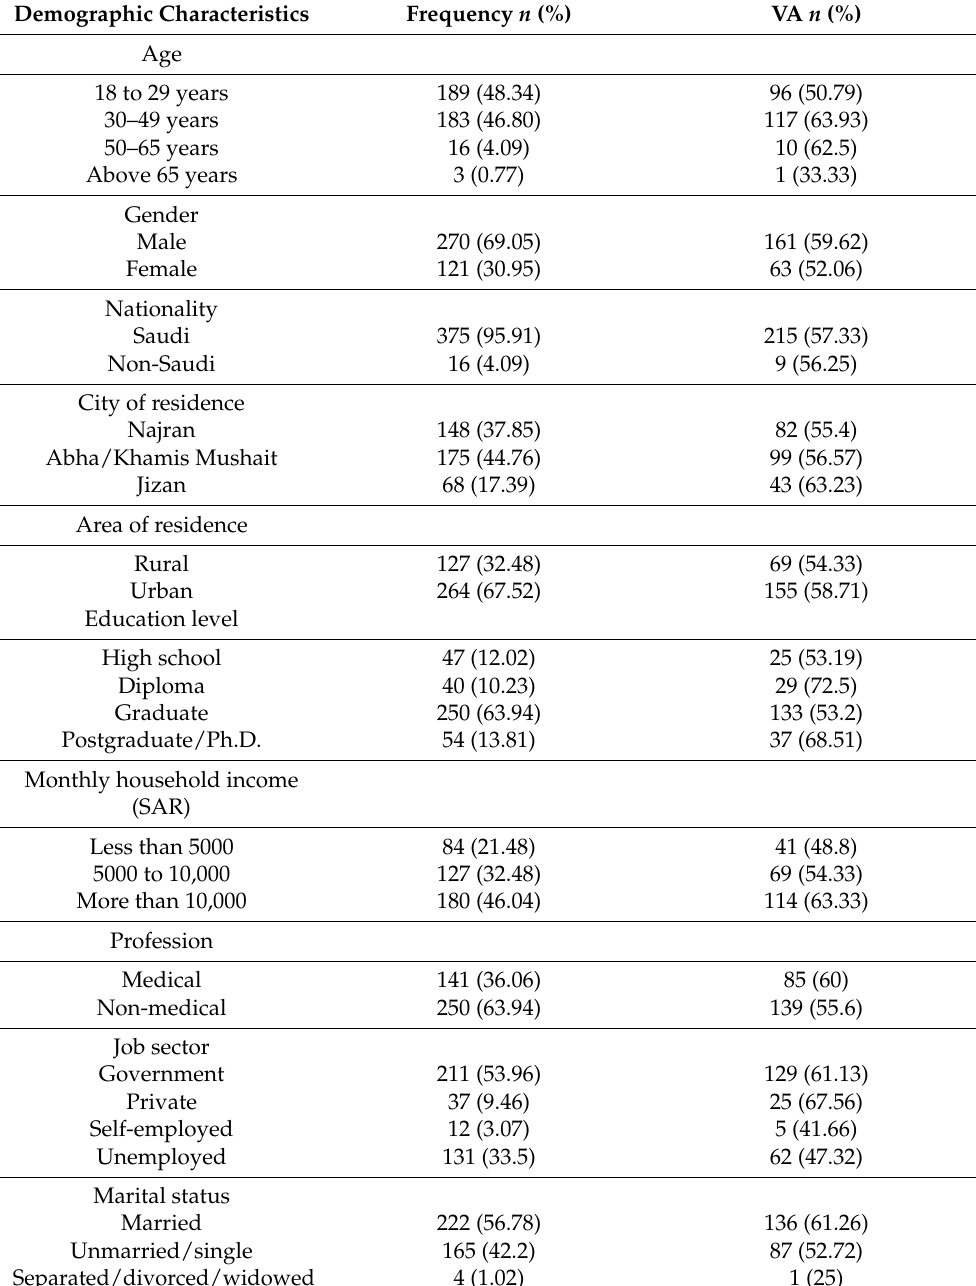
Table 1. Demographic characteristics of participants and vaccine acceptability (VA) ( n =